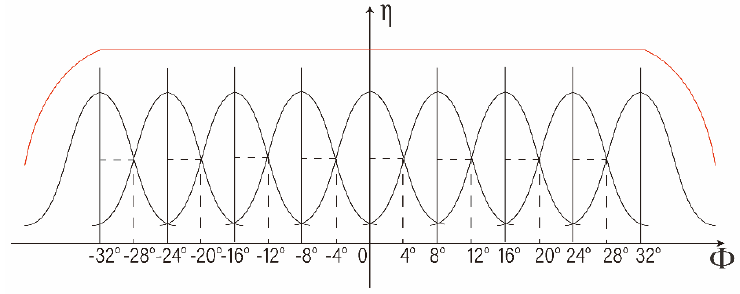
Figure 11. Light transmission efficiency curve of a fixed light guide system.